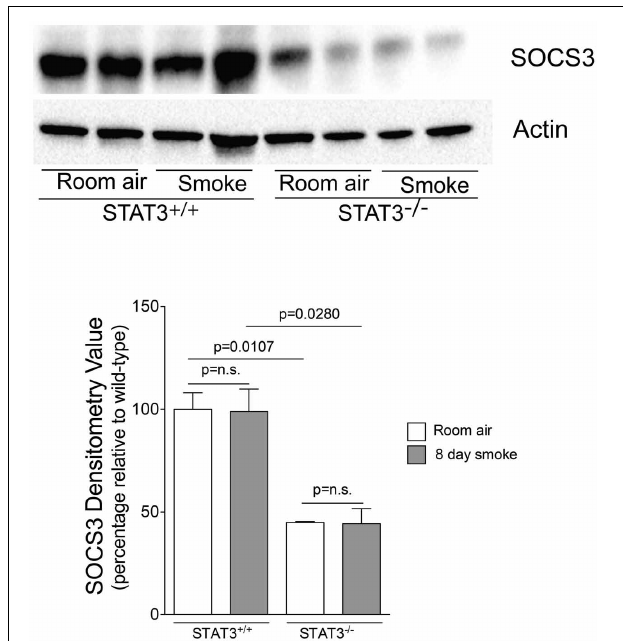
FIGURE 9 | Loss of STAT3 gives a trend increase in smoke induced Bcl-2 phosphorylation in mouse lungs. Lungs from STAT3 + / + and STAT3 − / − mice exposed to room air or smoke for 8 days were homogenized and p-Bcl-2, Bcl-2, and actin were detected by immunoblot. Each group had replicates of 3. Densitometry analysis was performed and results are represented as p-Bcl-2 protein relative to air-exposed STAT3 + / + mice. Bcl-2 levels were also used to normalize protein loading and are reflected in graph shown